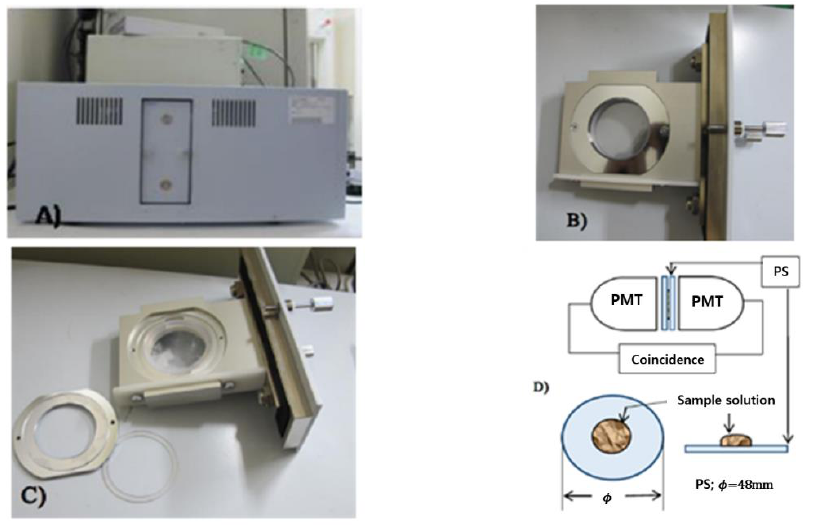
Figure 5. A system designed to measure low-energy beta rays [31].